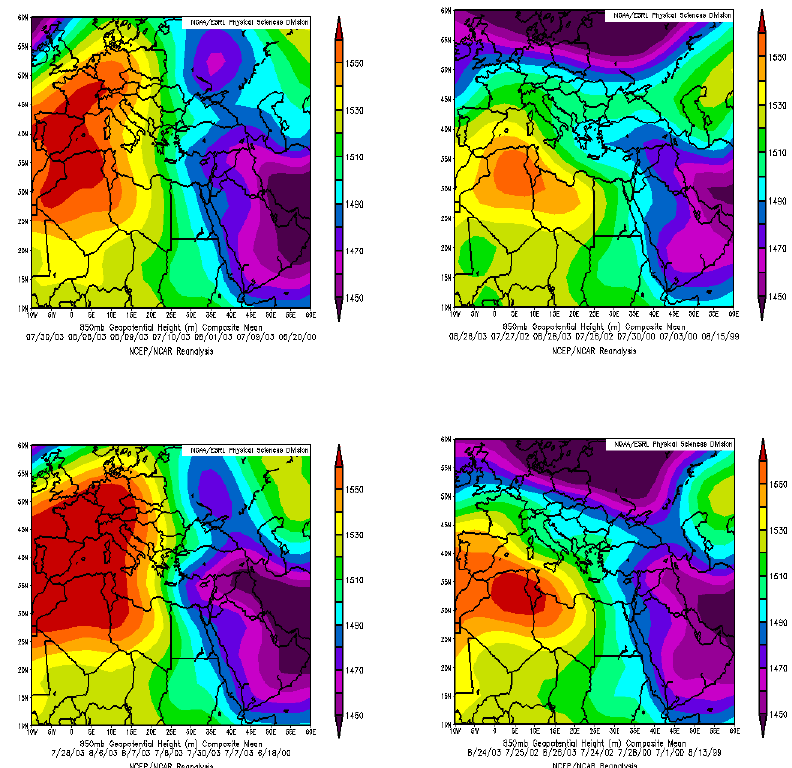
Fig. 9. Composite weather maps of geopotential heights at 850hPa of the 7% of the days with the highest ozone concentrations at the 1500–5000m layer (left column) and of the 7% of the days with the lowest ozone concentrations at the 1500–5000m layer (right column) in Cairo, during the day of the measurement (1st row) and 2-days ago (2nd Figure 9. Composite weather maps of geopotential heights at 850 hPa of the 7% of the days 5 with the highest ozone concentrations at the 1500-5000 m layer (left column) and of the 7% of 6 the days with the lowest ozone concentrations at the 1500-5000 m layer (right column) in 7 Cairo, during the day of the measurement (1st row) and 2-days ago (2nd row). 8